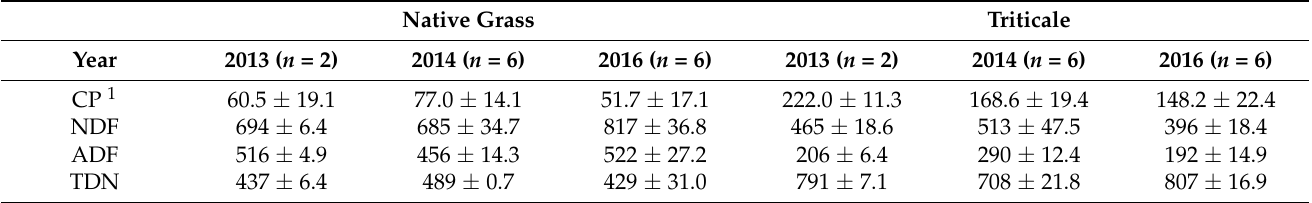
Table 1. Initial nutritive value (g kg − 1 of dry matter) of native grass and triticale pastures grazed at Tucumcari, NM, USA. Values are the mean ± standard deviation for each